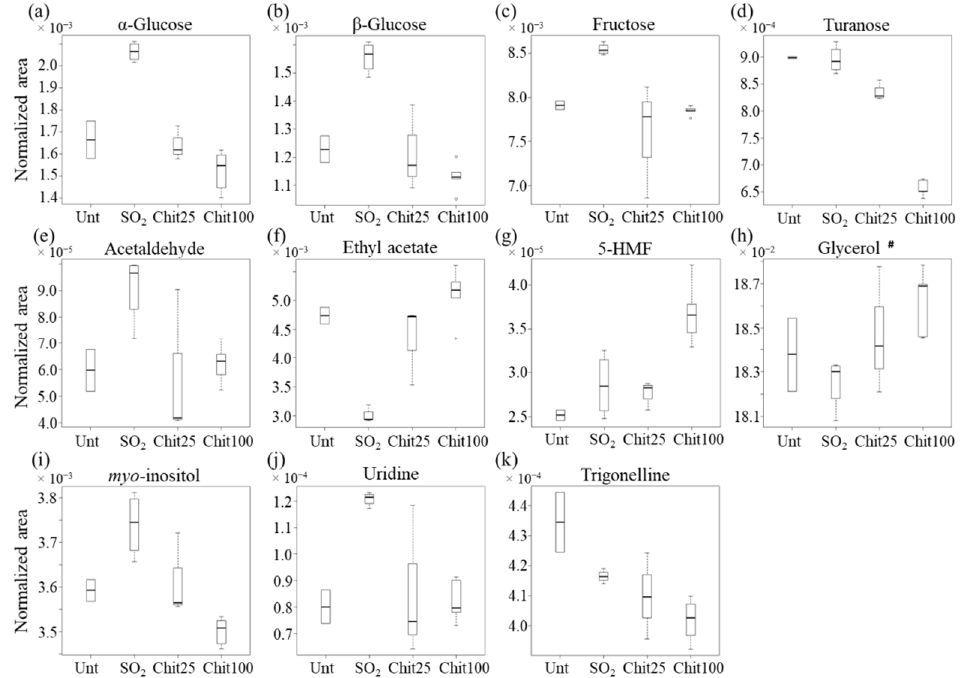
Figure 5. Boxplots illustrating the variations in the levels of sugars and other metabolites among the different conditions: untreated (Unt, n = 2), treated with 40 mg/L SO 2 (n = 5) and treated with 25 cm 2 (n = 3) or 100 cm 2 Ch-Ge films (n = 4), Chit25 and Chit100, respectively. ( a – d ): sugars— α -glucose, β -glucose, fructose, turanose; ( e – k ): other metabolites—acetaldehyde, ethyl